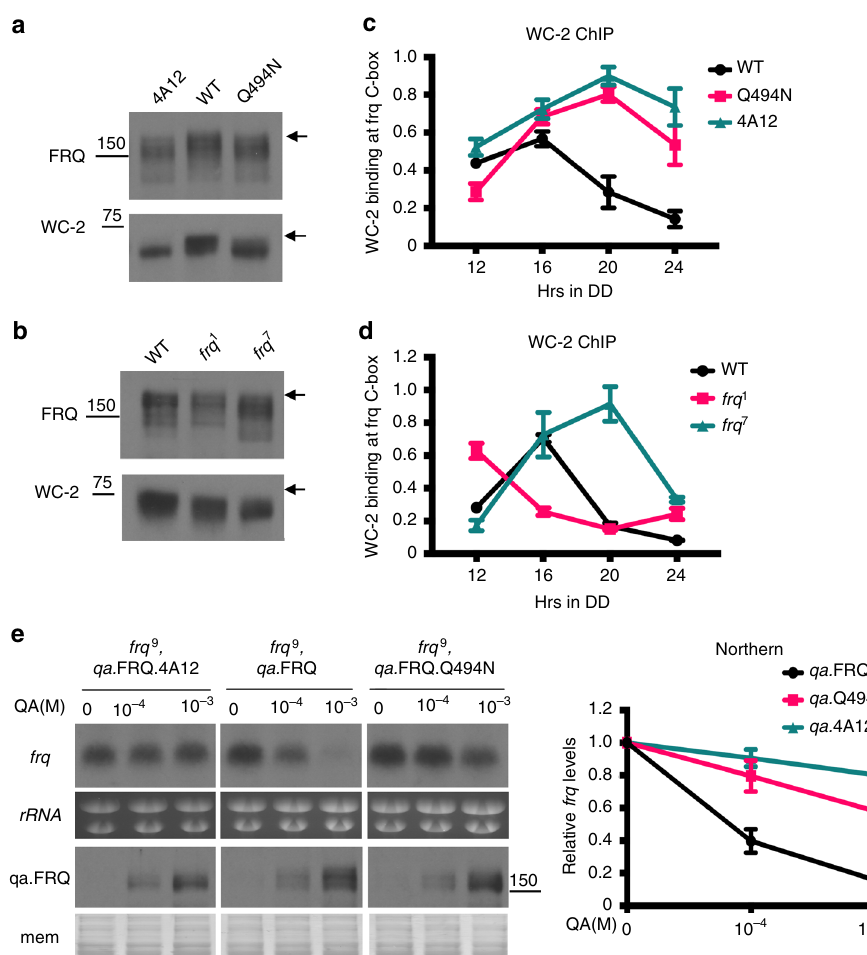
Fig. 4 FRQ-CK1a interaction determines FRQ activity in the negative feedback loop. a , b Western blot analyses showing the phosphorylation pro fi les of FRQ and WC-2 in the indicated strains. The arrows indicate the hyperphosphorylated FRQ or WC-2 species. The position of the molecular weight marker is indicated. c , d WC-2 ChIP assays showing that the relative enrichment levels of WC-2 at the c-box of frq promoter in the indicated strains collected at different time points in DD. Error bars are standard deviations ( n = 3). e Northern blot analysis showing the frq mRNA levels in the indicated strains after the induction of FRQ or its mutant form by QA at different concentrations. Error bars are standard deviations ( n = 3). Source data are provided as a Source Data fi